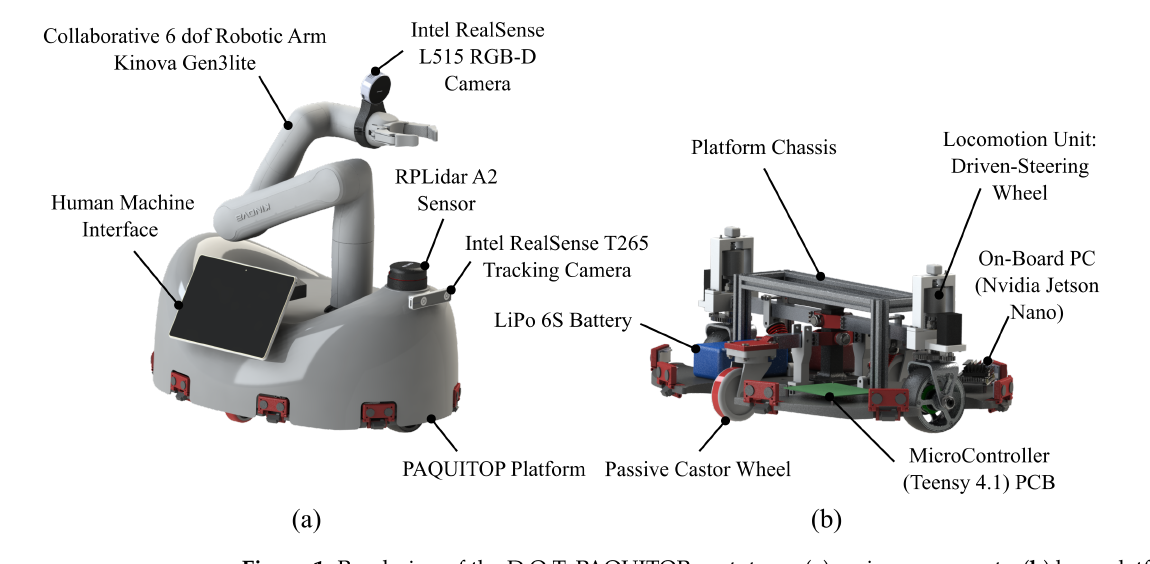
Figure 1. Rendering of the D.O.T. PAQUITOP prototype: ( a ) main components; ( b ) base platform de-